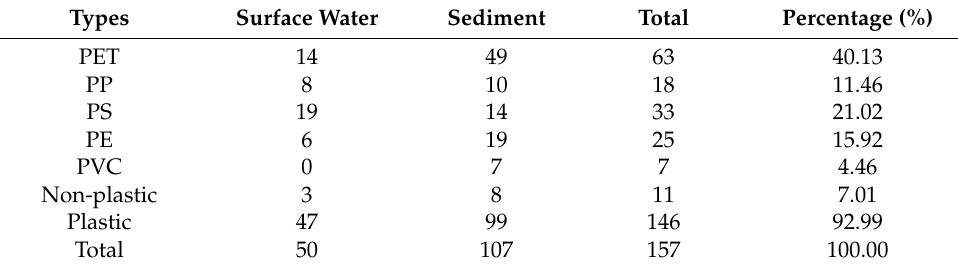
Table 3. Polymer types for the result of the micro-Raman